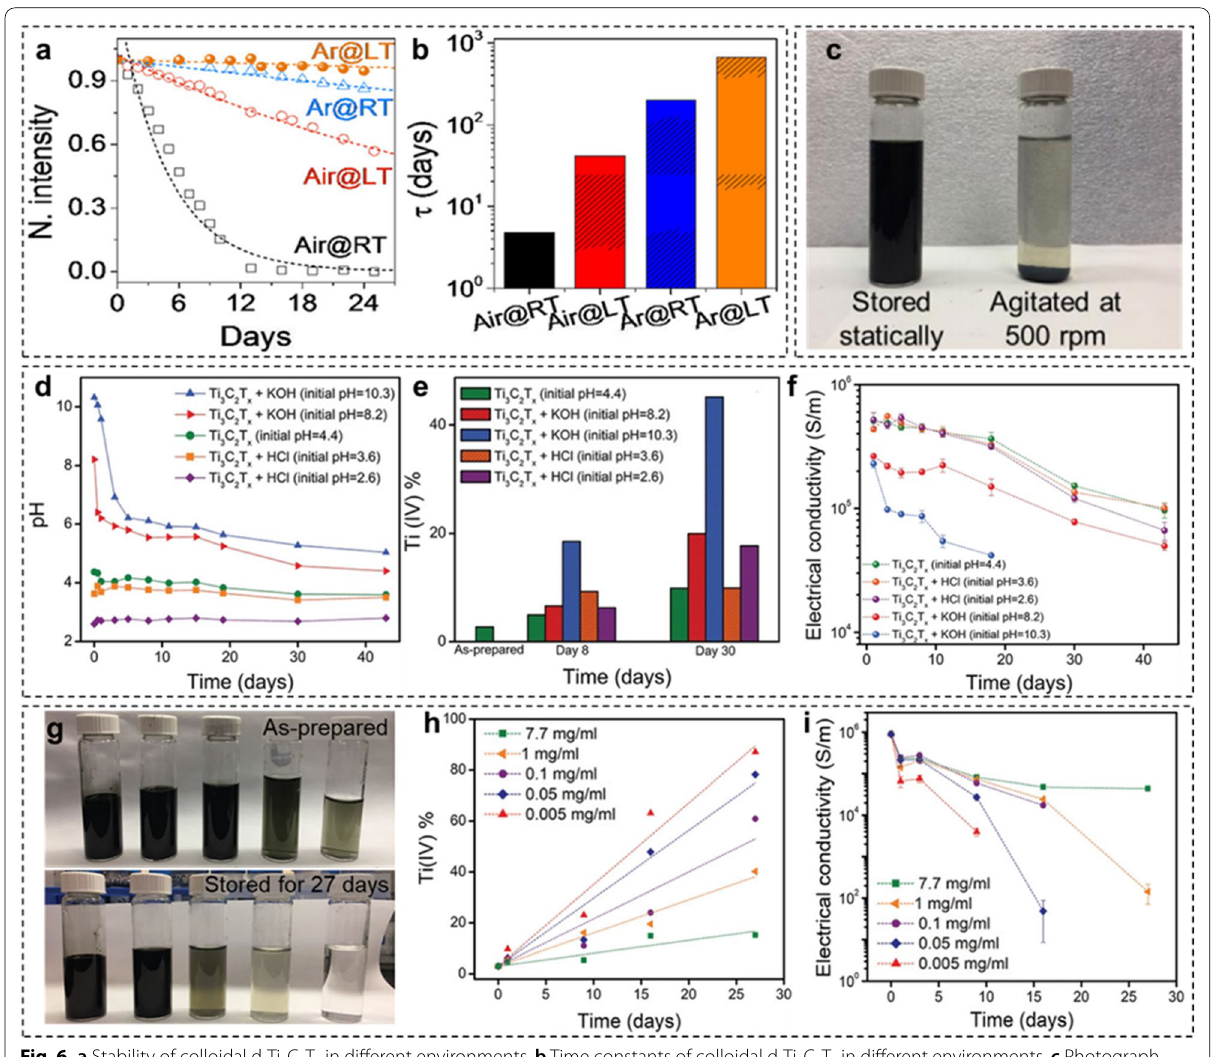
Fig. 6 a Stability of colloidal d-Ti 3 C 2 T x in different environments. b Time constants of colloidal d-Ti 3 C 2 T x in different environments. c Photograph of Ti 3 C 2 T x MXene dispersion stored statically (left) and by continuous stirring (right) after 20 days. d pH of Ti 3 C 2 T x MXene aqueous dispersion as a function of time. e Atomic percentage of Ti(IV) obtained by X ‐ ray photoelectron spectroscopy for Ti 3 C 2 T x . f Electrical conductivity of vacuum ‐